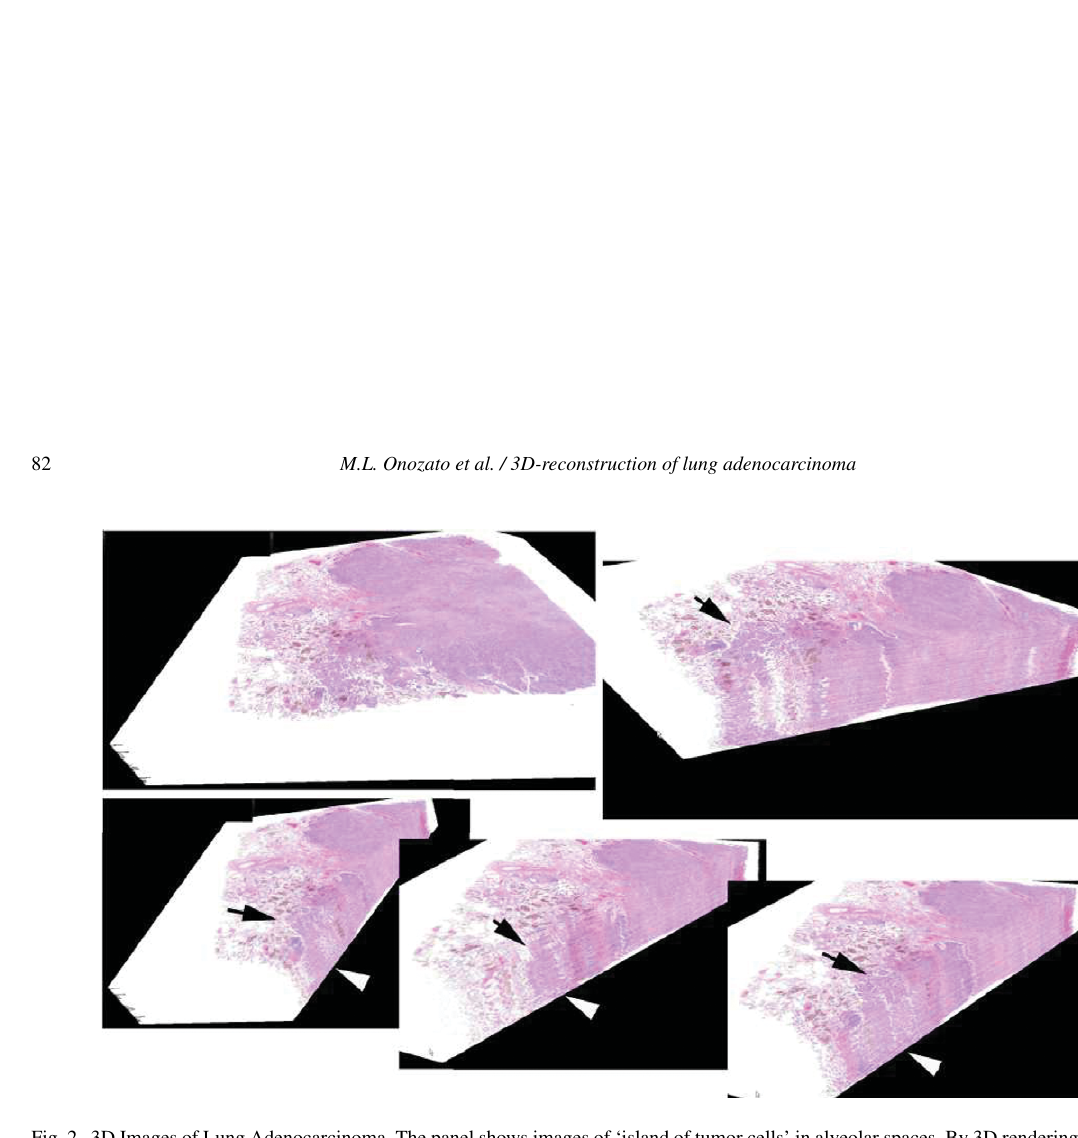
Fig. 2. 3D Images of Lung Adenocarcinoma. The panel shows images of ‘island of tumor cells’ in alveolar spaces. By 3D rendering these cells (arrow) extend into a deeper aspect of tissue, and are connected to other islands and/or the main tumor (arrow heads). These findings are difficult to identify with a 2D